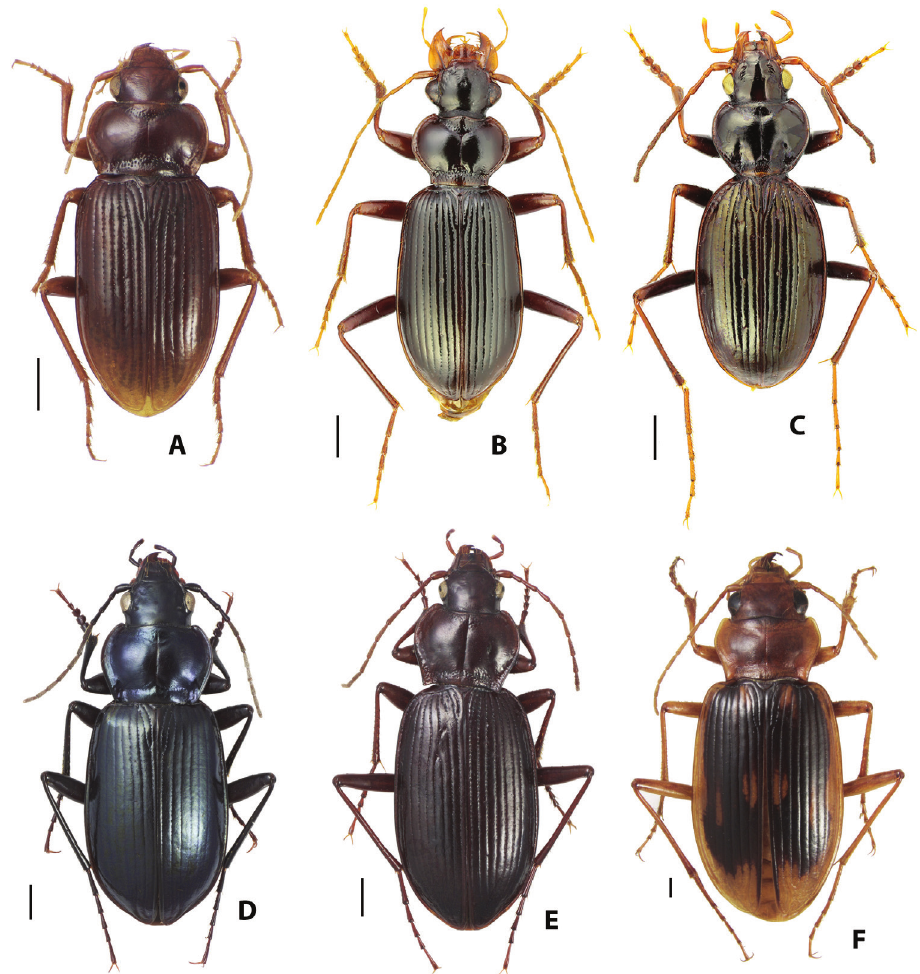
Figure 2. Habitus images of Nebriini A Leistus ( Nebrileistus ) nubivagus Wollaston B L. ( Leistus ) ferruginosus Mannerheim C Archastes solitarius (Ledoux & Roux) D Nippononebria ( Vancouveria ) virescens (Horn) E Nebria ( Oreonebria ) castanea Bonelli F N. ( Eurynebria ) complanata (Linnaeus). Scale bars: 1.0 mm. Photograph credits: A, D–F David Maddison; B, C Alexander